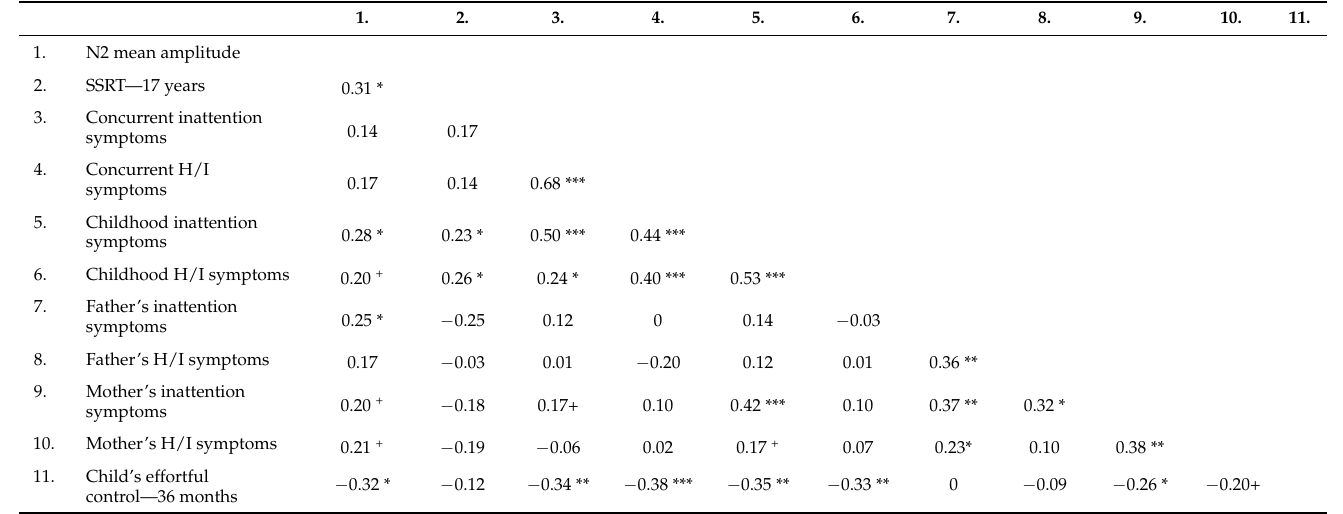
Table 3. Pearson Correlations among Study